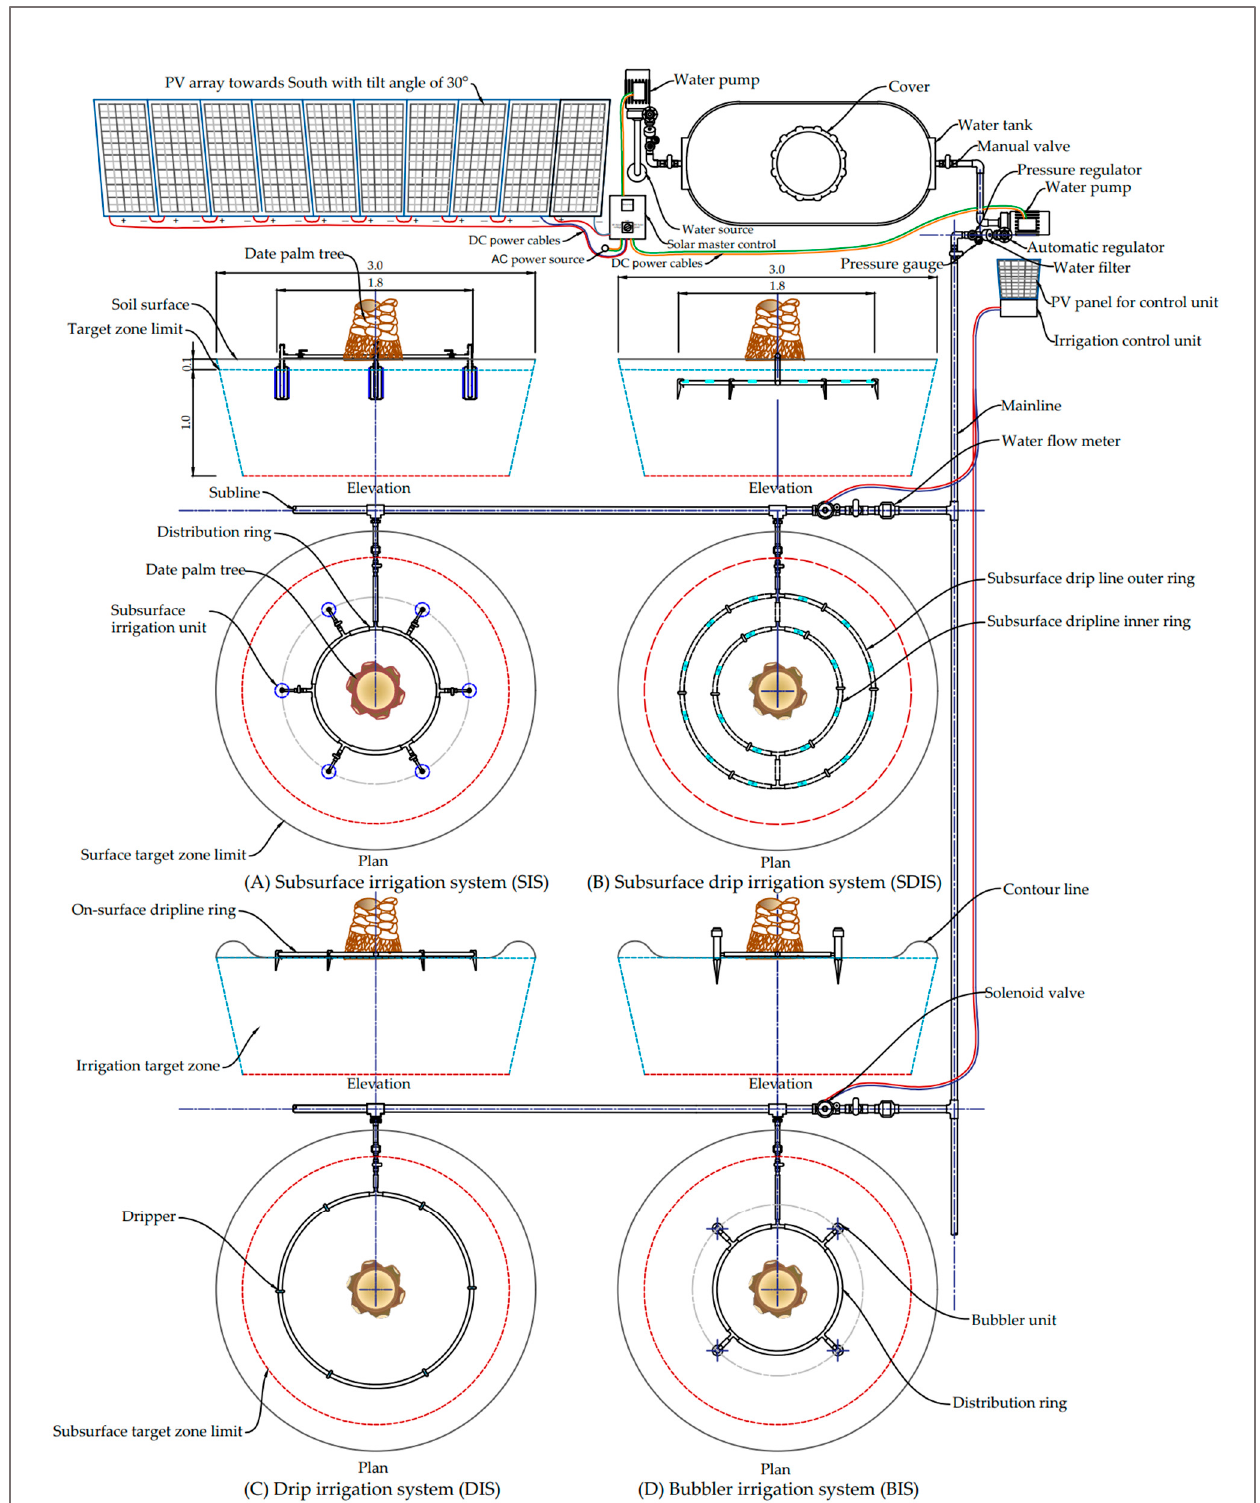
Figure 1. A schematic diagram of the experimental setup of the four solar-powered micro irrigation systems: ( A ) subsurface irrigation (SIS), ( B ) subsurface drip irrigation (SDIS), ( C ) drip irrigation (DIS), and ( D ) bubbler irrigation (BIS) connected with the solar PV system.